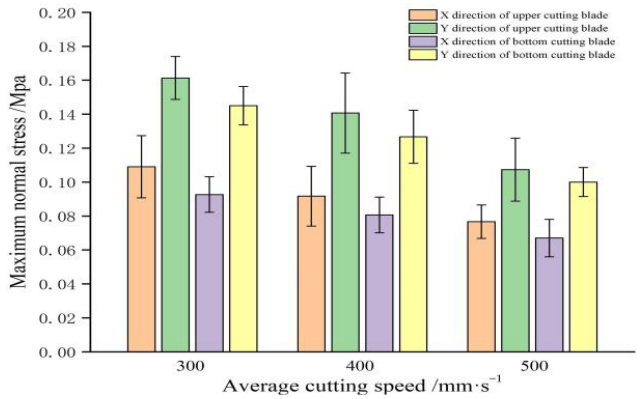
Figure 13. Maximum normal cutting stress at different average cutting speeds used in the physical tests.